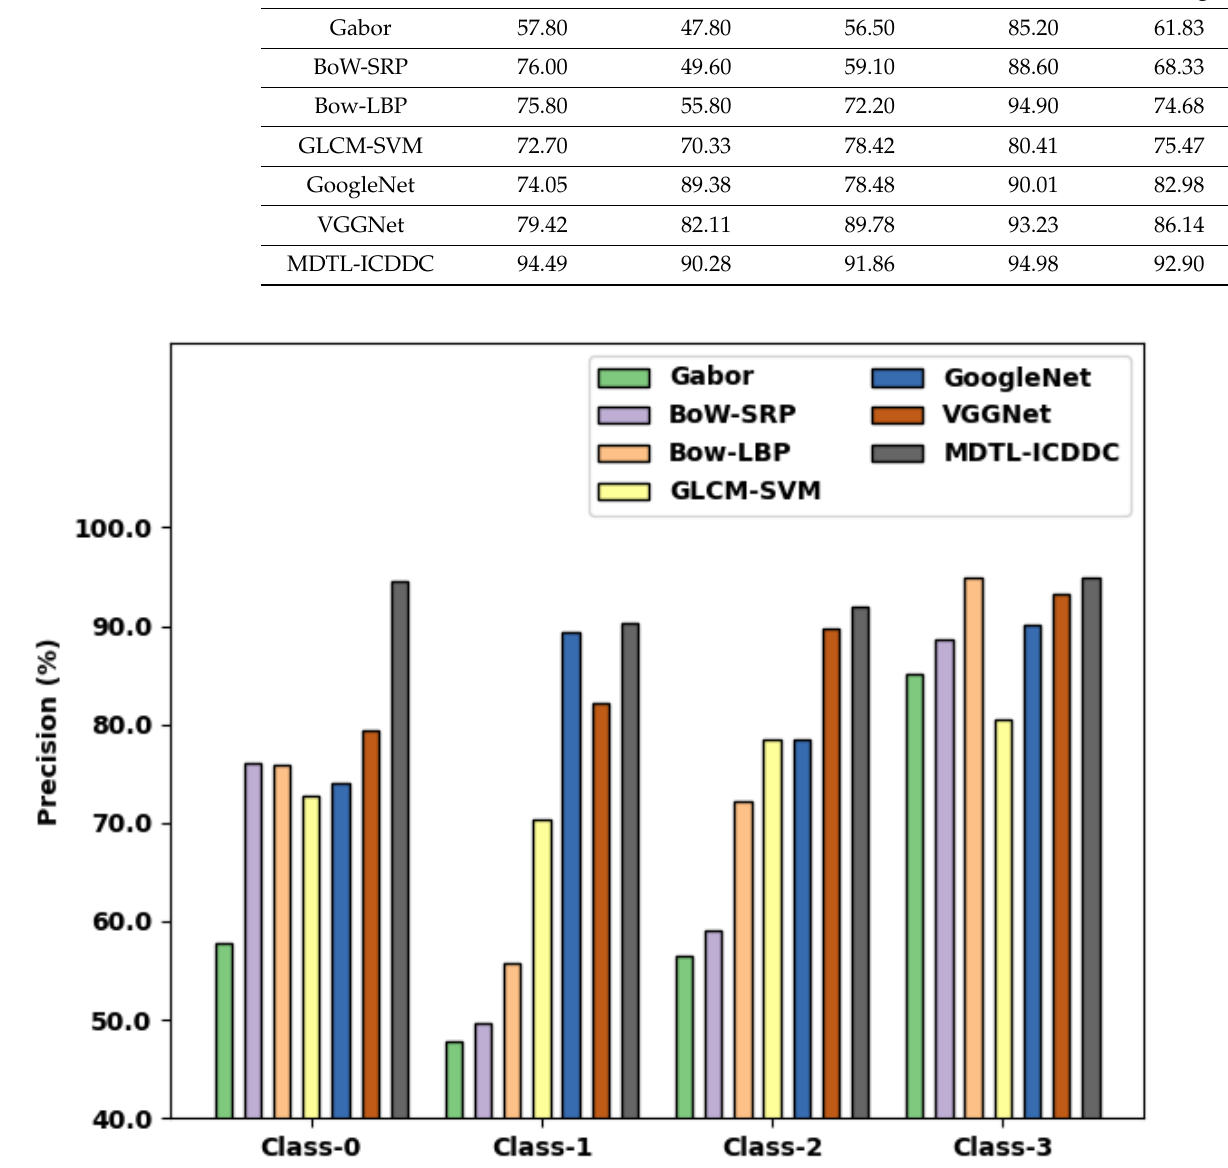
Figure 11. Precision analysis of MDTL-ICDDC technique under various classes.